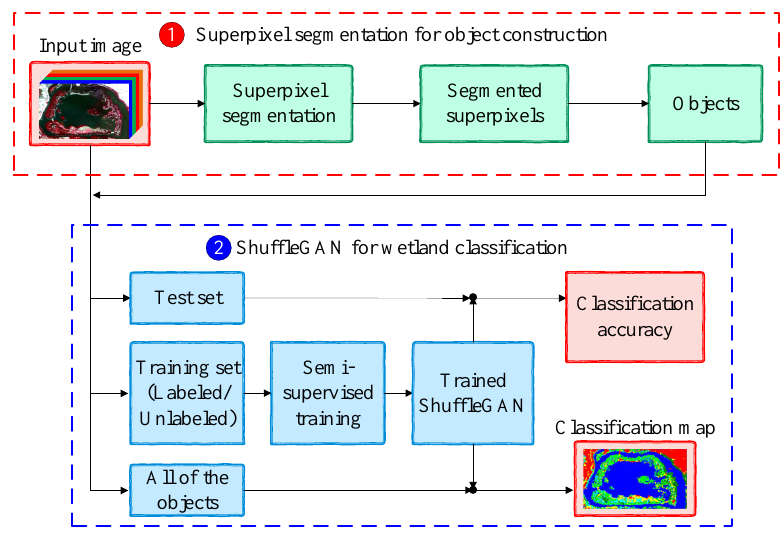
Figure 1. General architecture of the proposed